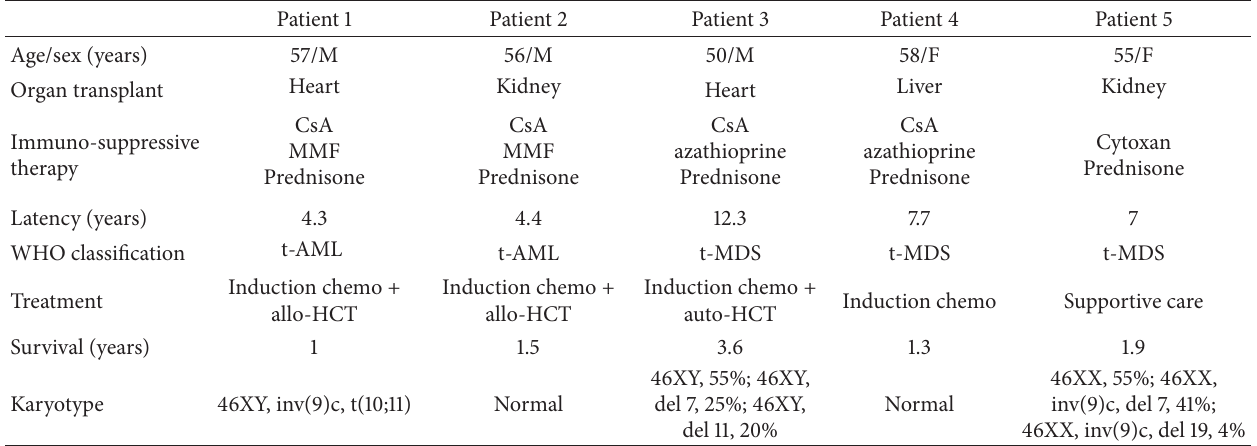
Table 2: Post-solid organ transplant t-MNs at the University of